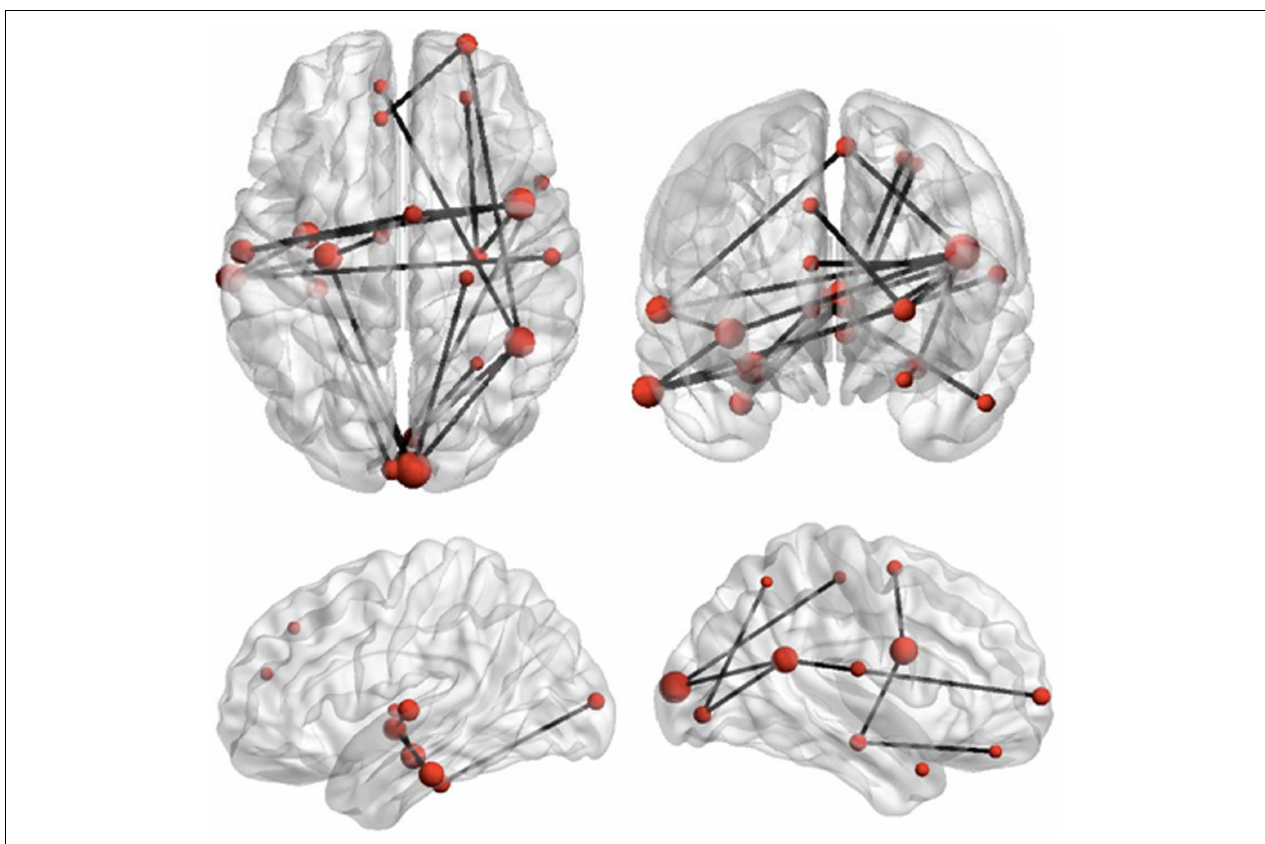
(ED1) in children with ASD ( p = 0.01).The size of the regions in this network, indicated by the size of the red dots, represents increasing magnitude of group differences in task-dependent connectivity strength for these